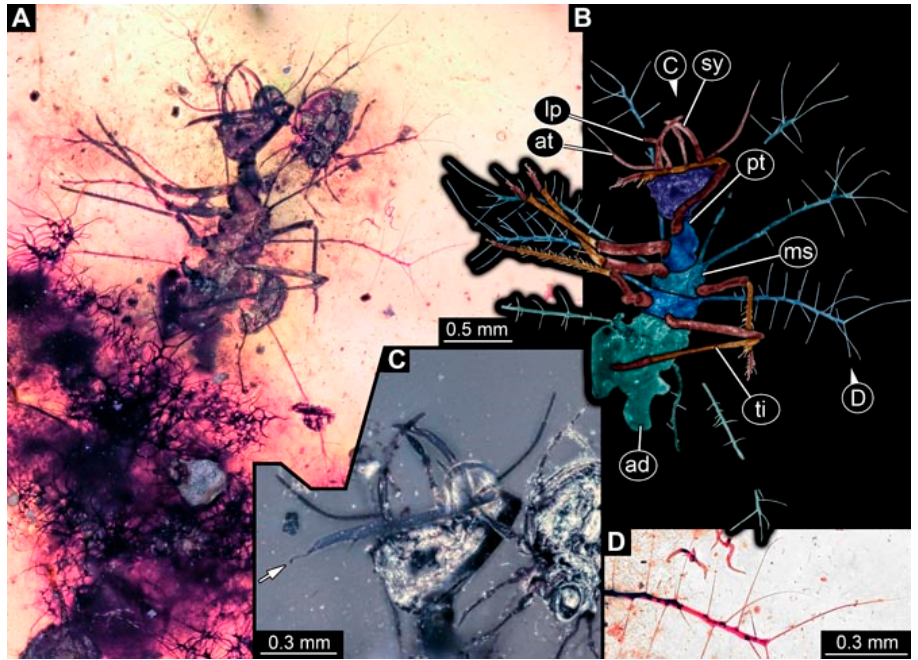
Figure 2. Specimen 4821 (BUB 3066); Myanmar amber. ( A ) Ventral view. ( B ) Ventral view, colour- marked. ( C ) Close-up of head capsule in ventral view and close-up of trunk appendage with empodium (arrow). ( D ) Close-up of protrusion in ventral view. Abbreviations: ad = abdomen; at = an- tenna; lp = labial palp; ms = mesothorax; pt = prothorax; sy = stylet; ti = tibia.